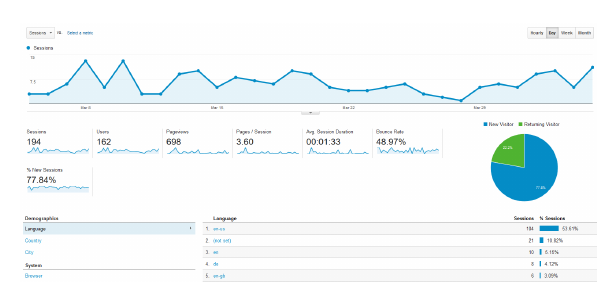
Figure 12. Statistics of the SC Newsletter page visits since April 17, 2013 (since the publication of Vol. 7, No. 1). Figure 13. Dashboard of Google Analytics for the